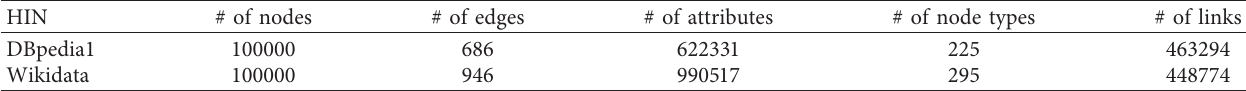
Table 1: Statistics of HINs constructed based on DBpedia and